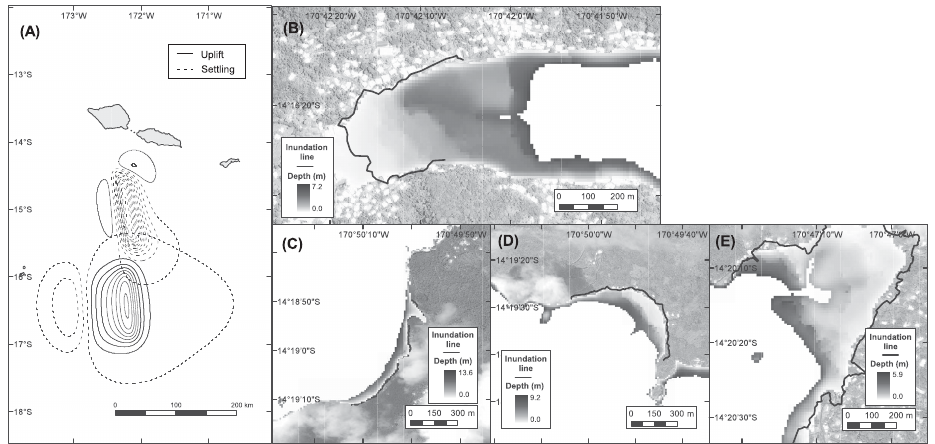
at the DART gauges. The tsunami source model is used for modeling tsunami inundation.